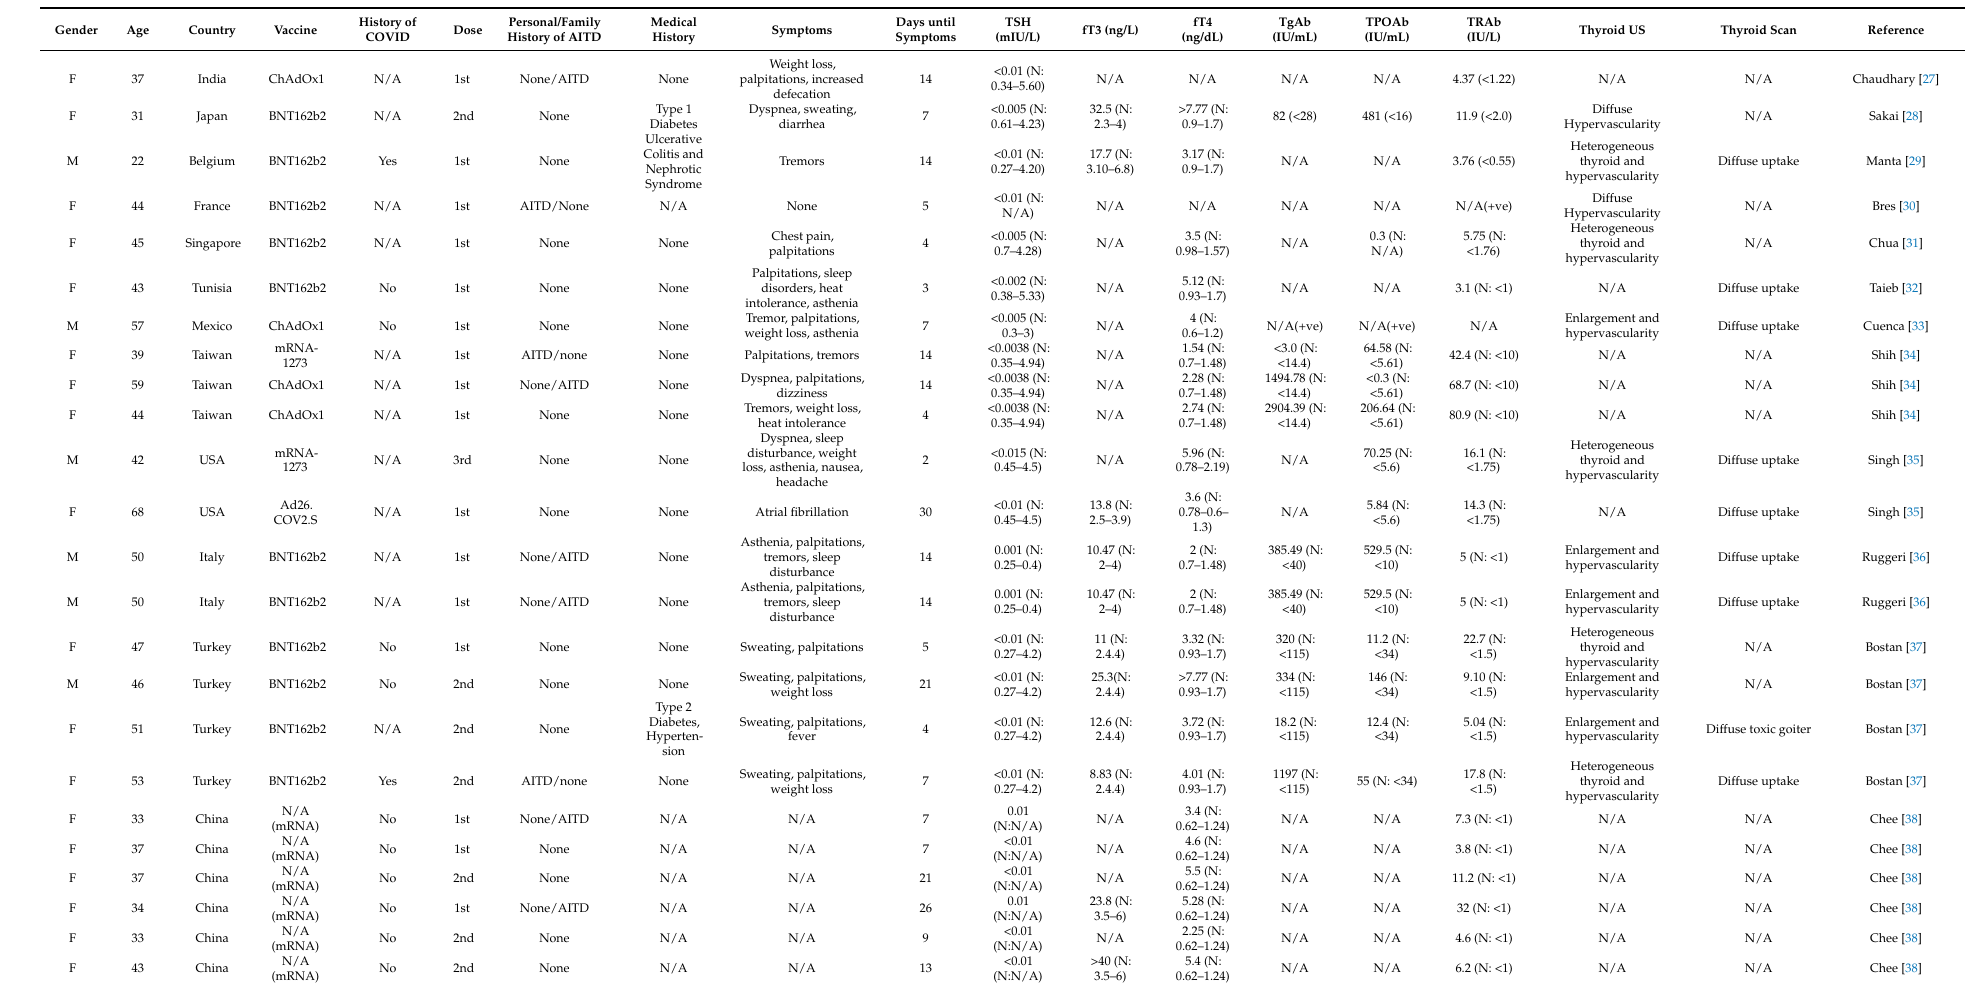
Abbreviations: F: female; M: male; COVID-19: coronavirus disease 2019; AITD: autoimmune thyroid disease; SLE: Systemic lupus erythematosus; GD: Graves’ disease; DM: diabetes mellitus; AFib: atrial fibrillation; GI: gastro-intestinal; MMI: methimazole; N/A: not available; +ve: positive; TSH: thyrotropin; fT3: free triiodothyronine; fT4: free tiroxine; TPOAb: anti-thyroid peroxidase antibody; TgAb: anti-thyroglobuline antibody; TRAb: TSH receptor antibody; US: